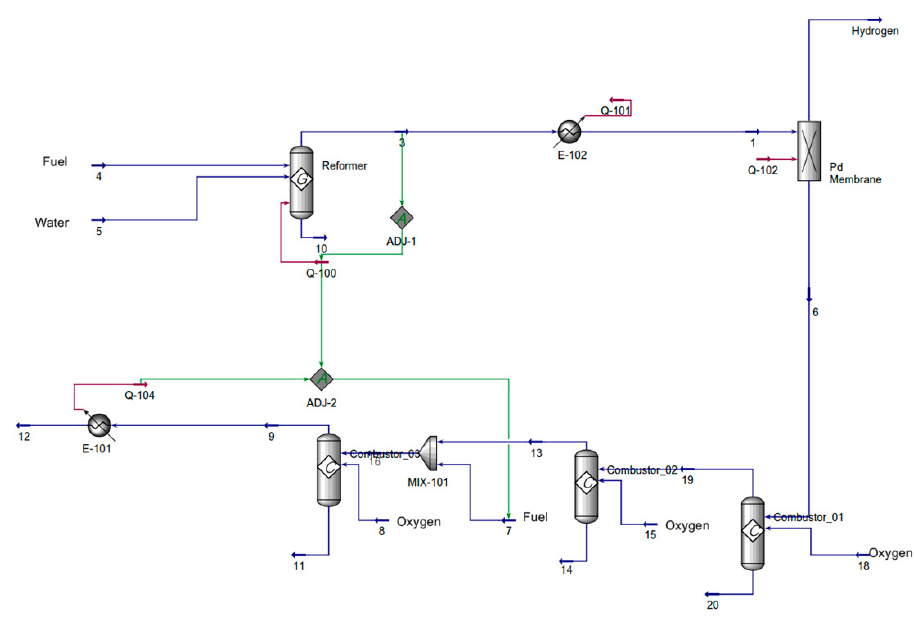
Figure 2. Fuel-reformer modeling.